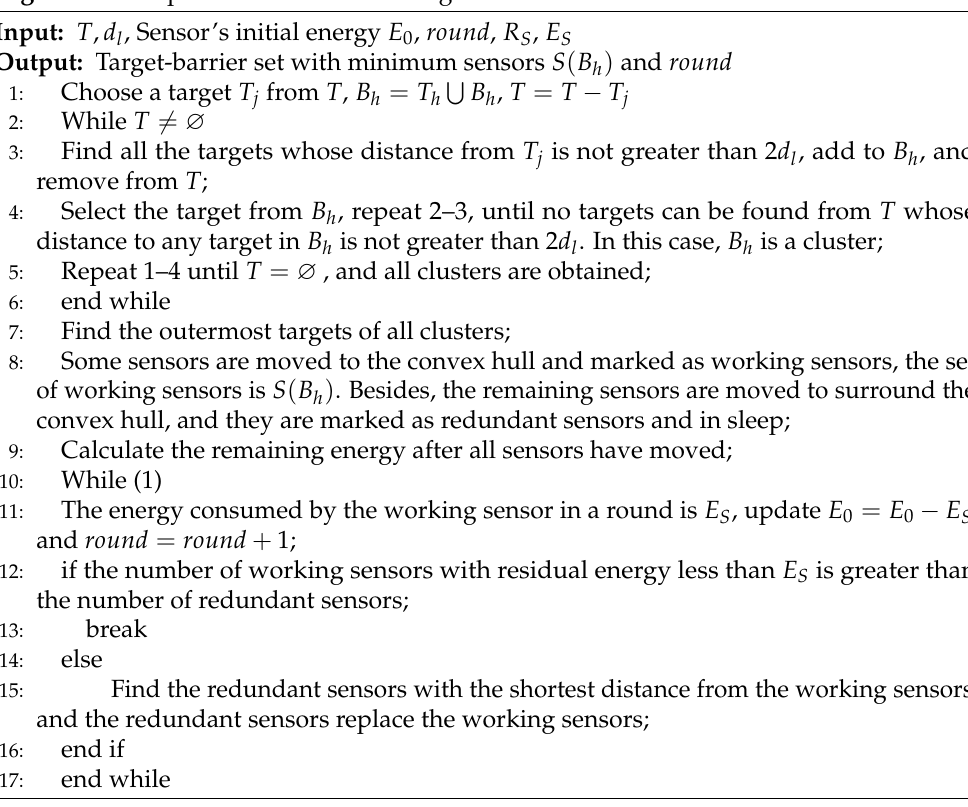
Algorithm 1 Implementation of CHA